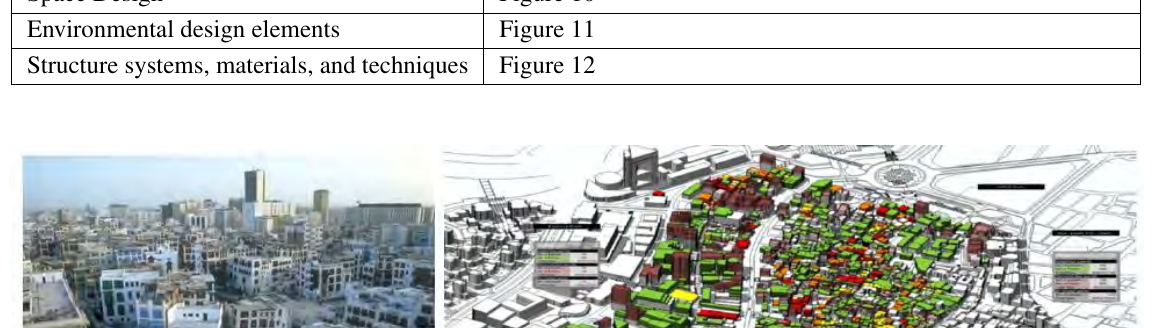
Figure 9 old Islamic city pattern with narrow not straight